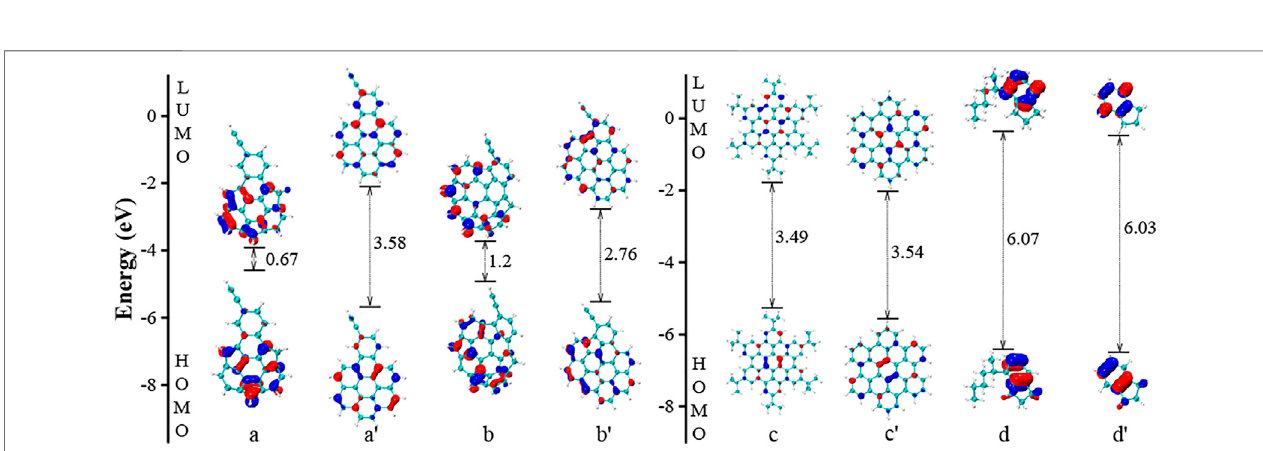
FIGURE4| TheHOMOandLUMOelectronicstructuresofPAHswith – C n H m substitutions.The a ’ , b ’ , c ’ ,and d ’ refertoasimpli fi edcon fi gurationof a , b , c, and d by removing the functional groups, respectively.